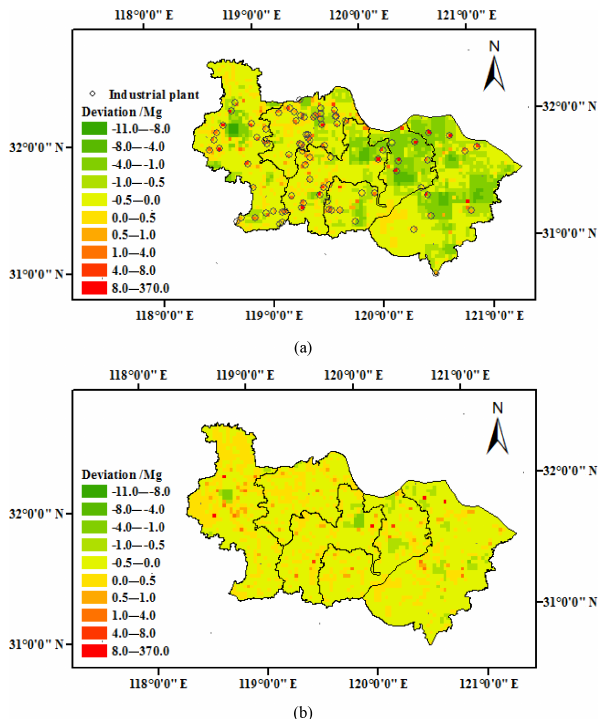
Figure 6. The spatial distributions of the deviations (JS-MEIC, unit: Mg) between JS-prior and MEIC-prior (a) and those between JS- posterior and MEIC-posterior (b)